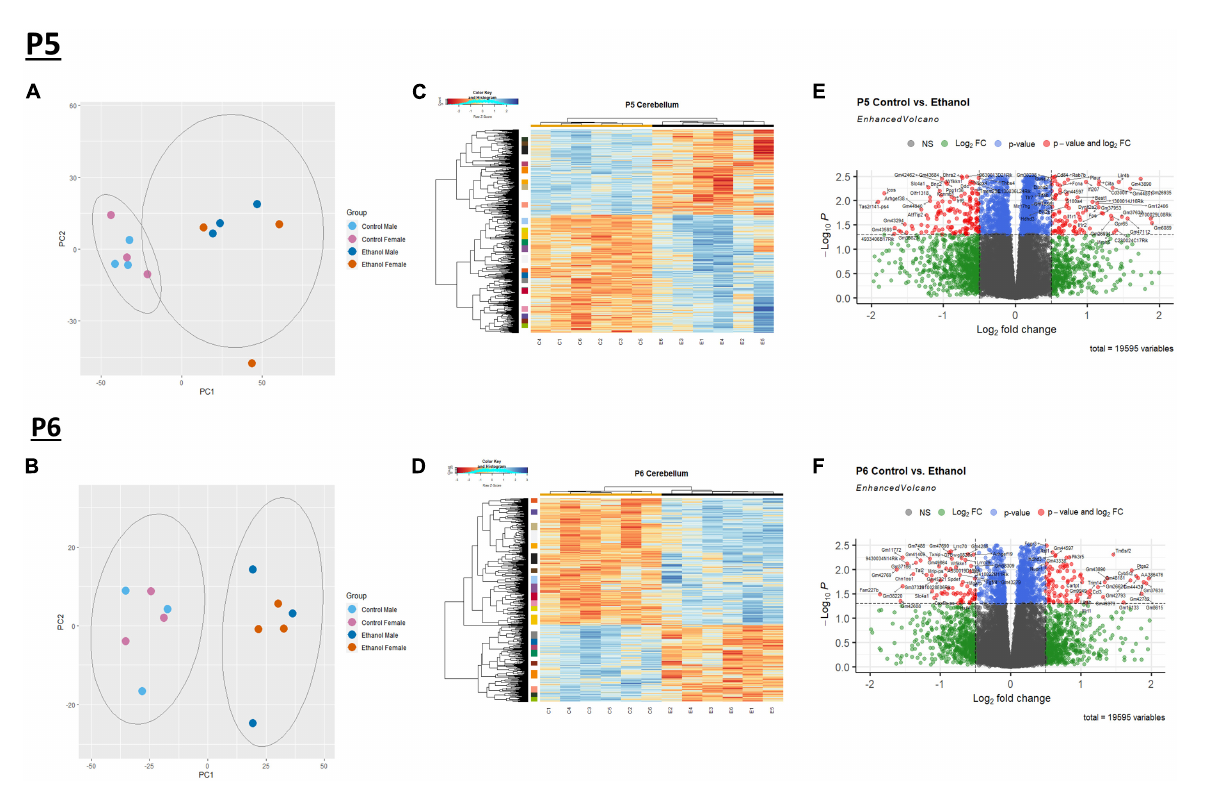
FIGURE1 Ethanol-induced differential gene expression in the cerebellum. Principle component analysis (PCA) of the variance of genes in the cerebellum between ethanol (E) and control (C) at P5 (A) and P6 (B) . A heatmap and hierarchical clustering dendrogram of the of relative gene expression across samples for the significantly (adj. p < 0.05) altered genes for P5 (C) and P6 (D) . A volcano plot displaying fold change versus adjusted p -value of all detected genes in the cerebellum at P5 and P6. 2,440 of 19,595 total identified transcripts at P5 (E) and 1,348 of 19,595 total identified transcripts at P6 (F) displayed an adjusted p < 0.05 and Log 2 fold change ≥ 0.5 or ≤ –0.5, shown in red. PCA, heatmaps, and volcano plots ( Enhanced Volcano package) were generated using R statistical software. n = 3 males and 3 females per treatment group E or